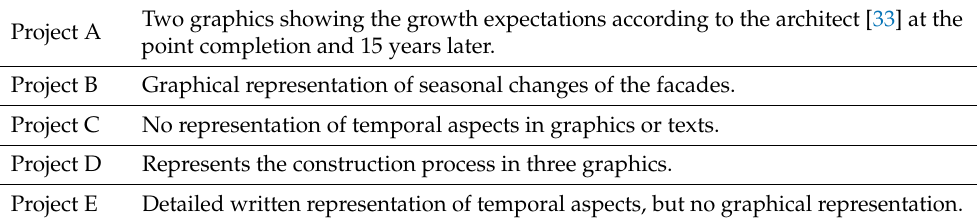
Table 3. Found representations of temporal aspects in the five analysed